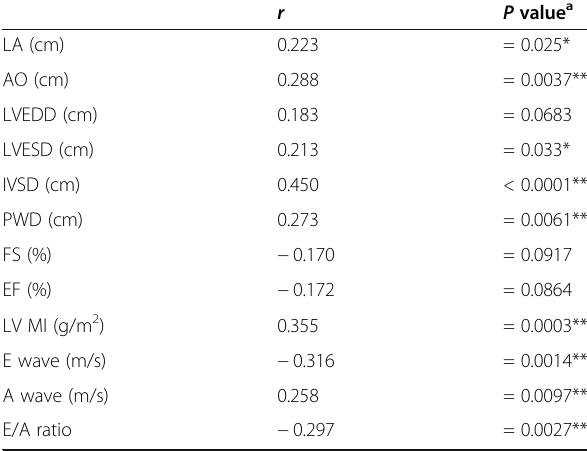
Table 5 Correlations of echocardiographic data and postoperative BMI